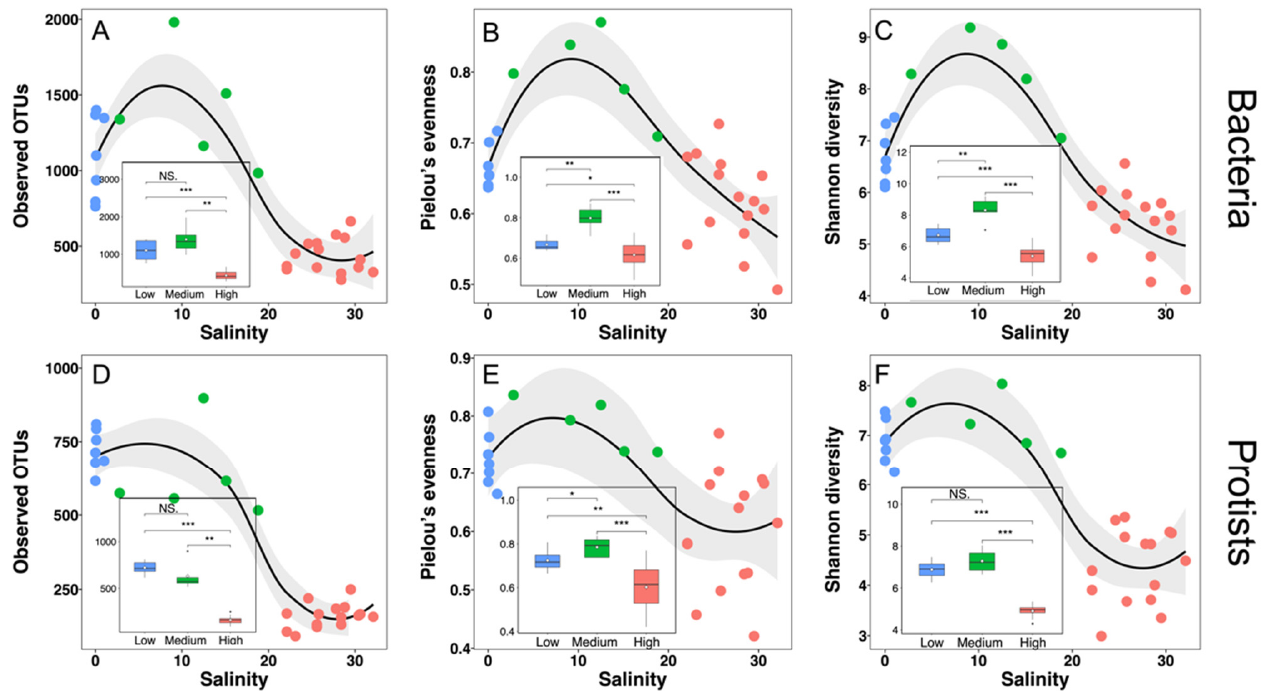
Figure 5. Variation of three alpha diversity indices of bacteria ( A – C ) and protists ( D – F ). Scatter plots displayed the three diversity indices as a function of salinity, and the shaded area is the 95% confidence interval of the smooth-fitting curve. Box plots showed the distribution of each index in low-salinity cluster ( n = 7), medium-salinity cluster ( n = 5) and high-salinity cluster ( n = 15), and the white diamond represents the mean value of each set of data. According to whether the data conformed to the normal distribution, the differences of each alpha diversity index between the two clusters were tested using Student’s t test or Wilcoxon test. * p < 0.05; ** p < 0.01; *** p < 0.001; NS, not significant.